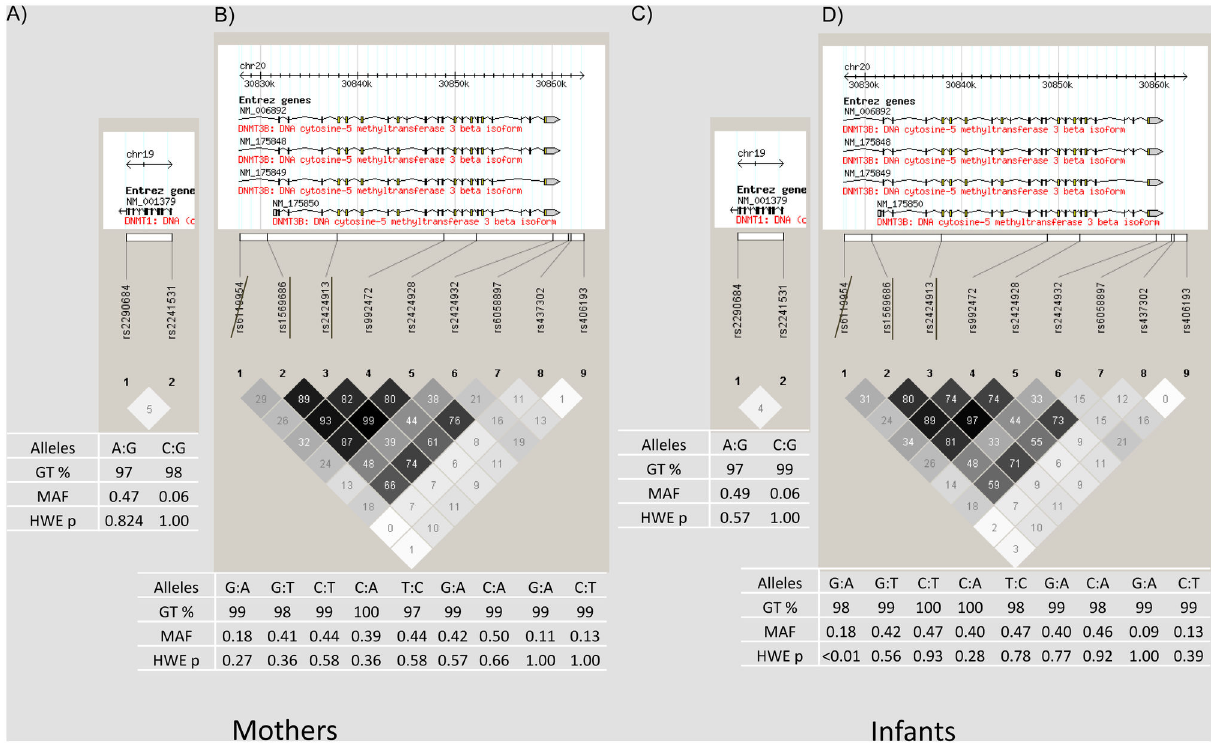
Figure 1. Linkage disequilibrium and SNP frequencies across DNMT genes in mothers and infants. Alleles = Major: Minor, GT % = genotyping success rate (mothers total N = 333, infants total N = 454), MAF = minor allele frequency, HWE p = Hardy Weinberg Equilibrium p-value. Single underscore = putative functional SNPs; strikethrough = excluded from analysis. doi: